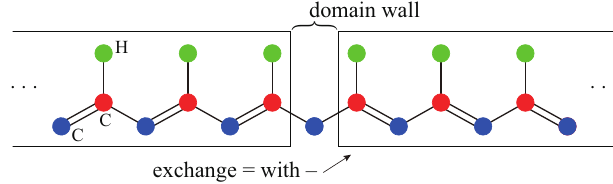
Figure 2. Two semi-infinite polyacetylene chains with a domain wall, which connects two different m and m . A double bond is shorter than a long bond and a Peierls lattice dimerized phases labeled − distortion is present. The directions of the double bonds vary in these two phases. Periodic boundary conditions cannot be imposed on this system as there is only one domain wall. Either a soliton or antisoliton is possible, but not